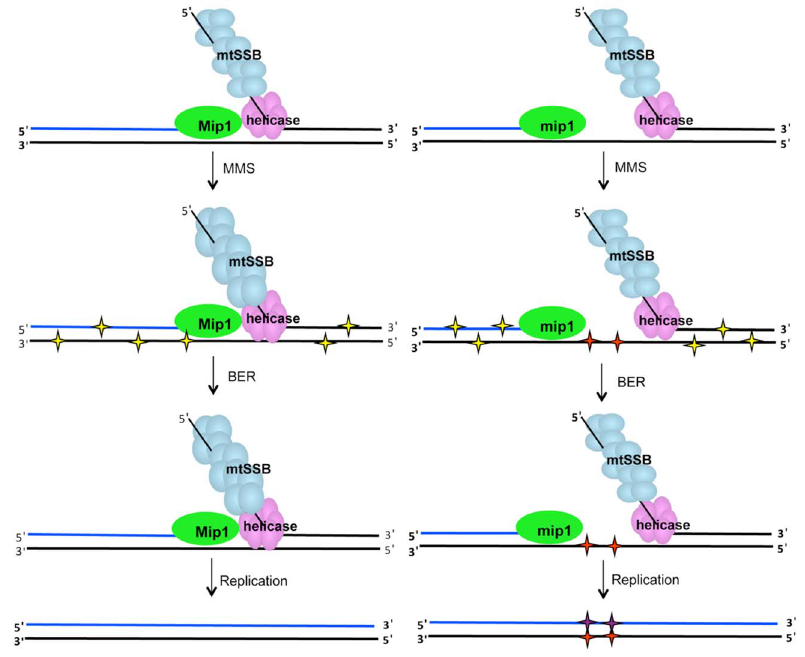
Figure 8. MMS-induced mutagenesis in Mip1 variants may be associated with unrepaired ssDNA damage. Under normal circumstances (left), single-stranded gaps at the replication fork are limited because of Mip1 processivity. However, reduced catalytic activity of the Mip1 disease variants (right scheme) results in the greater likelihood of stalling, which could produce long tracks of ssDNA if the helicase proceeds normally. When exposed to MMS, potentially mutagenic lesions in dsDNA (yellow stars) as well as N3-methylated cytosines in ssDNA (red stars) are produced. Although, BER is expected to correct the base damage in dsDNA, ssDNA lesions are not a BER substrate and are therefore unrepaired. Replication of the lesion is likely to result in incorporation of a cytosine opposite the N3-methylated cytosine to make the C:G R G:C mutation. BER, base excision repair; dsDNA, double-stranded DNA; MMS, methyl methanesulfonate; ssDNA, single-stranded DNA.